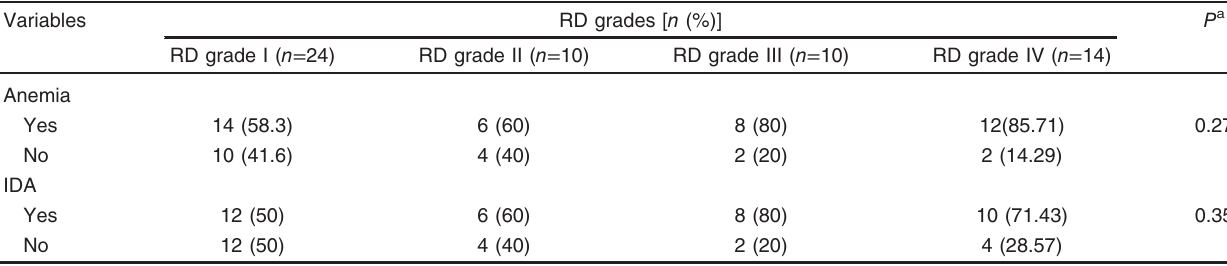
Table 5 Respiratory distress among patients regarding presence of anemia Variables